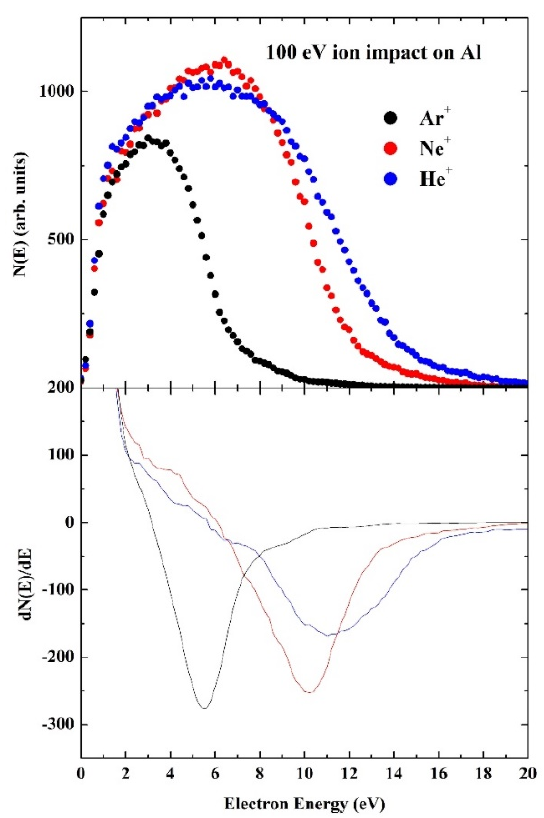
Figure 2. Top: Energy spectra N(E) acquired with the large angle spectrometer for 100 eV He + , Ne + and Ar + ions at Al surface. The incidence angle was Θ I = 80°. Bottom: derivatives dN(E)/dE.